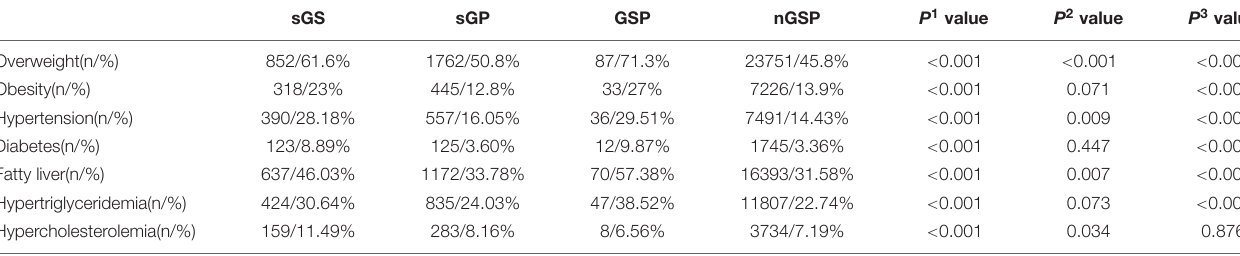
TABLE 4 | Prevalence of metabolic associated disease in gallbladder stones and gallbladder polyps.